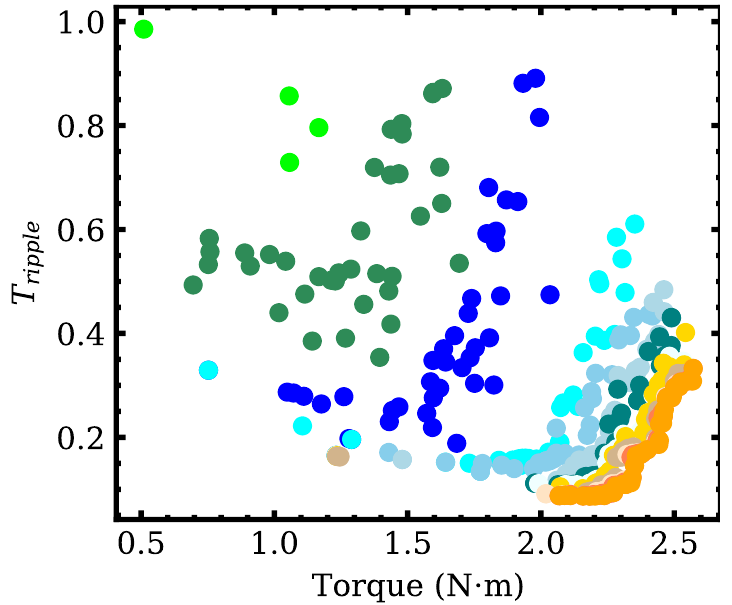
Figure 11. Obtained Pareto-front solution of every ten iterations.